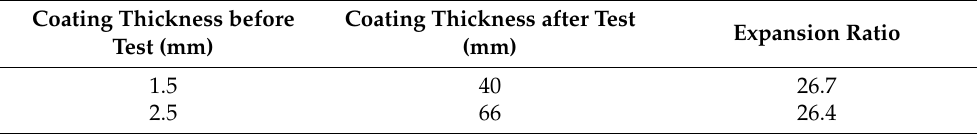
Table 8. Thickness statistics of IFC before and after the